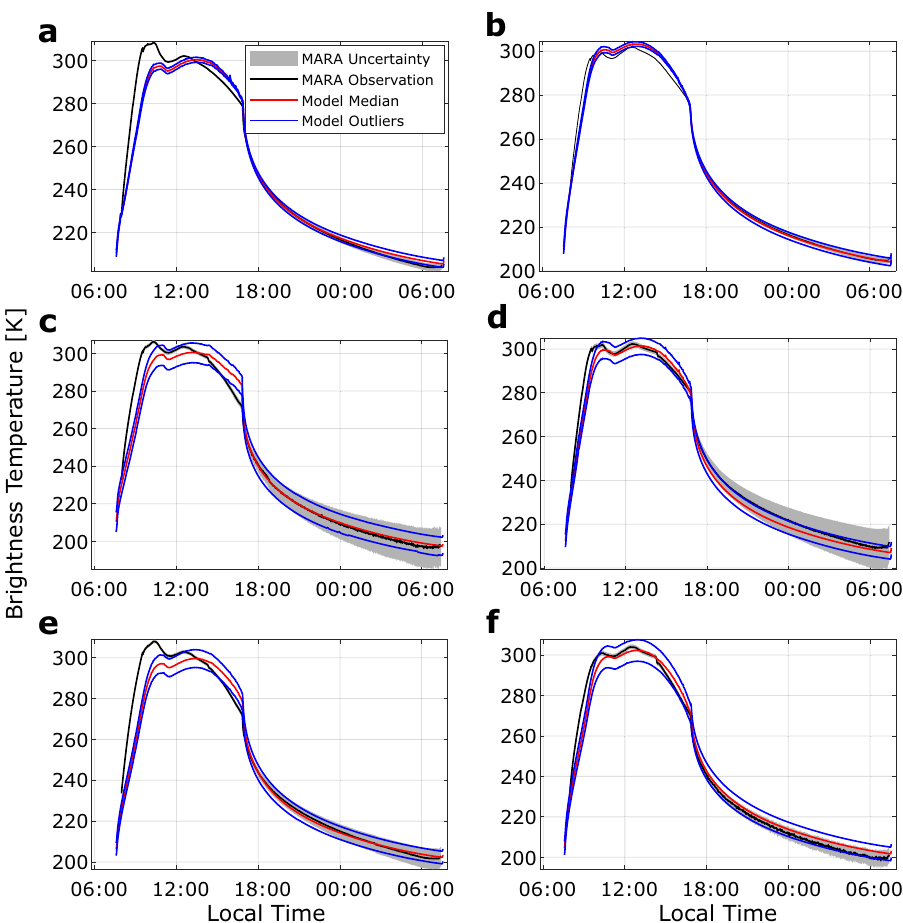
Fig. 2 Observed brightness temperature of all six instrument channels as a function of local time in comparison to modelled observation. a Brightness temperature (black) observed in the Silicon-Long-pass (SiLP) is shown as a function of local time (given in hours, de fi ned by 1/24 of Ryugu ’ s rotation period) along with the corresponding uncertainty (2 σ with σ the standard deviation) given by grey shades. Red line indicates the median of modelled observation based on the posterior parameter estimation. Blue lines are models based on the range of outliers of the posterior within 1.5 times the interquartile range from the 25th and 75th percentile, respectively. b – f As for a but for the other instrument channels, b 8 – 12 µ m fi lter (W10), c 5.5 – 7 µ